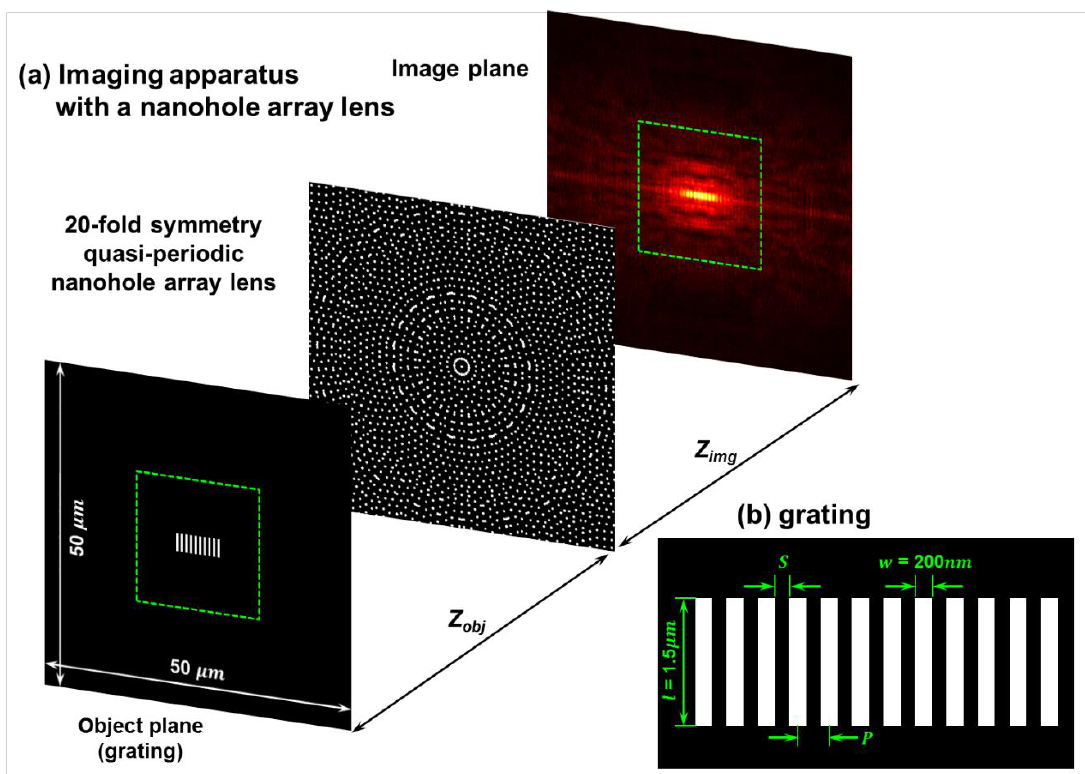
Figure 9. Imaging of gratings by a 20-fold symmetry quasi-periodic nanohole array lens. ( a ) shows the imaging of grating structures by using a 20-fold symmetry quasi-periodic nanohole array, while ( b ) schematically displays the grating structures. The grating structures are placed on an object plane at Z obj = 13.5 μm. The length and width of each nanoslit are fixed at l = 1.5 μm and w = 200 nm, respectively. The grating periods P between the constituent nanoslits are 600 nm and 650 nm, indicating that the overall areas of the two designed gratings are 6.8 × 1.5 μm 2 and 7.35 × 1.5 μm 2 . The geometric center of the grating structures is aligned with the central axis of the nanohole array lens. By using the 20-fold symmetry quasi-periodic nanohole array as a lens to image the gratings, Figure 10a,b show the imaged patterns of different gratings with period P of 600 nm and 650 nm, respectively. The gratings consist of 12 nanoslits whose width is 200 nm and length is 1.5 μm. The total width of each grating is 5.7 μm and 6.15 μm. By varying the imaging distance from the array, the best resolved images are produced at 13.5 μm. As shown, at the center of the effective imaging area of around 6 μm in diameter, the nanoslits in gratings can be resolved. The smallest resolving distance is around 300 nm, equal to the edge-to-edge distance between the nanoslits. However, slits are not imaged clearly at the two ends of the grating. Such results, again, demonstrate the effective imaging area when using a quasi-periodic nanohole array as a